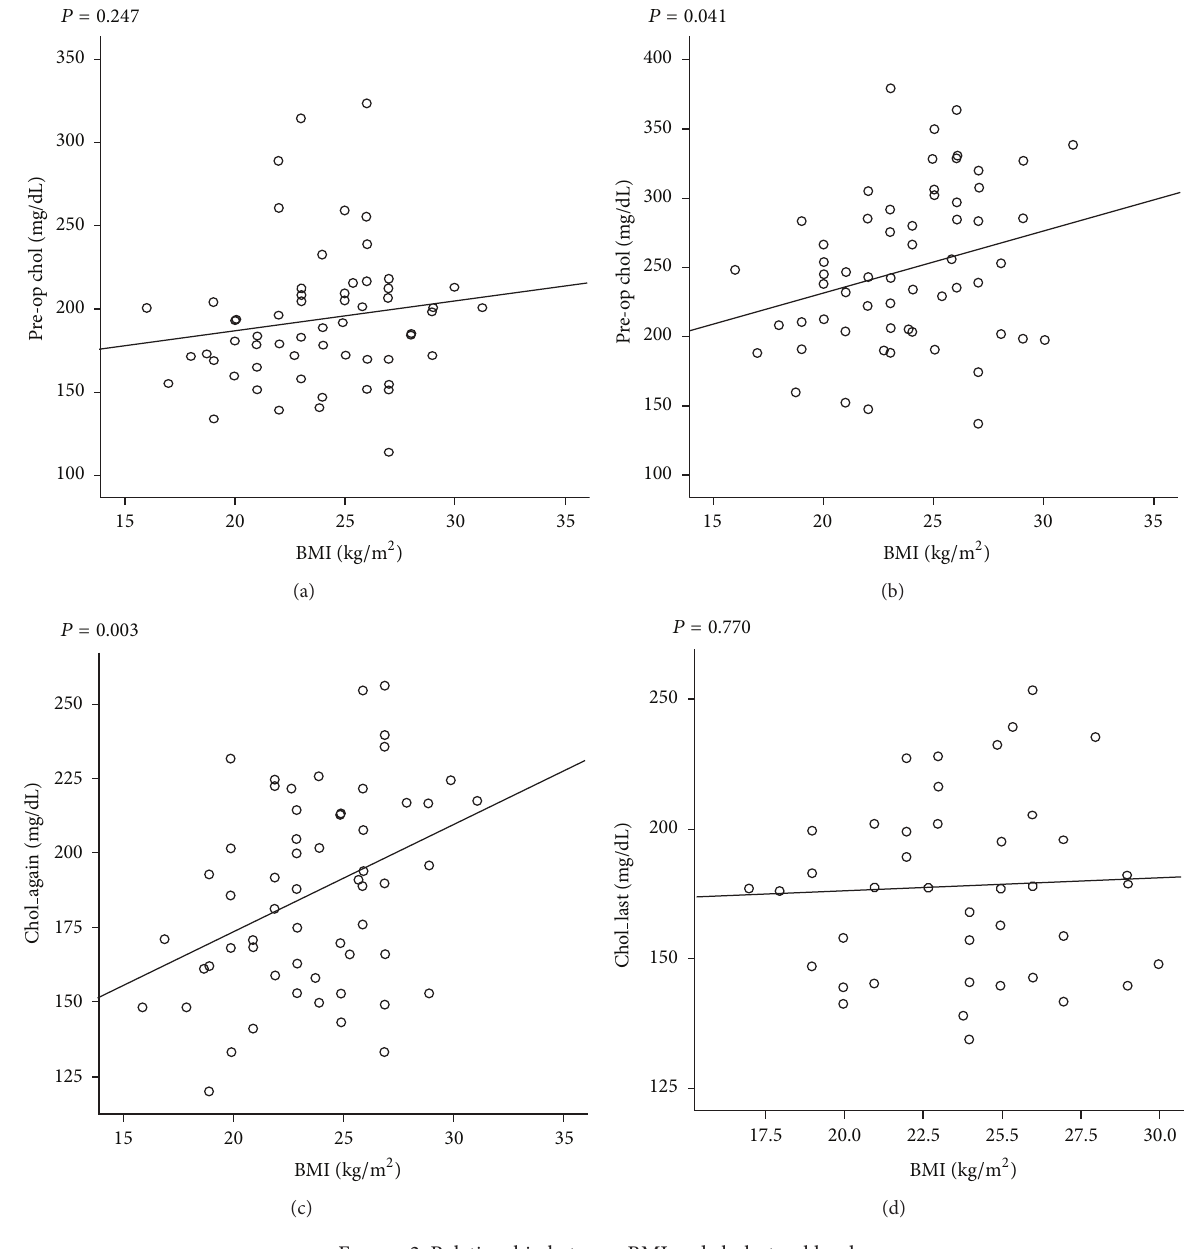
Figure 2: Relationship between BMI and cholesterol